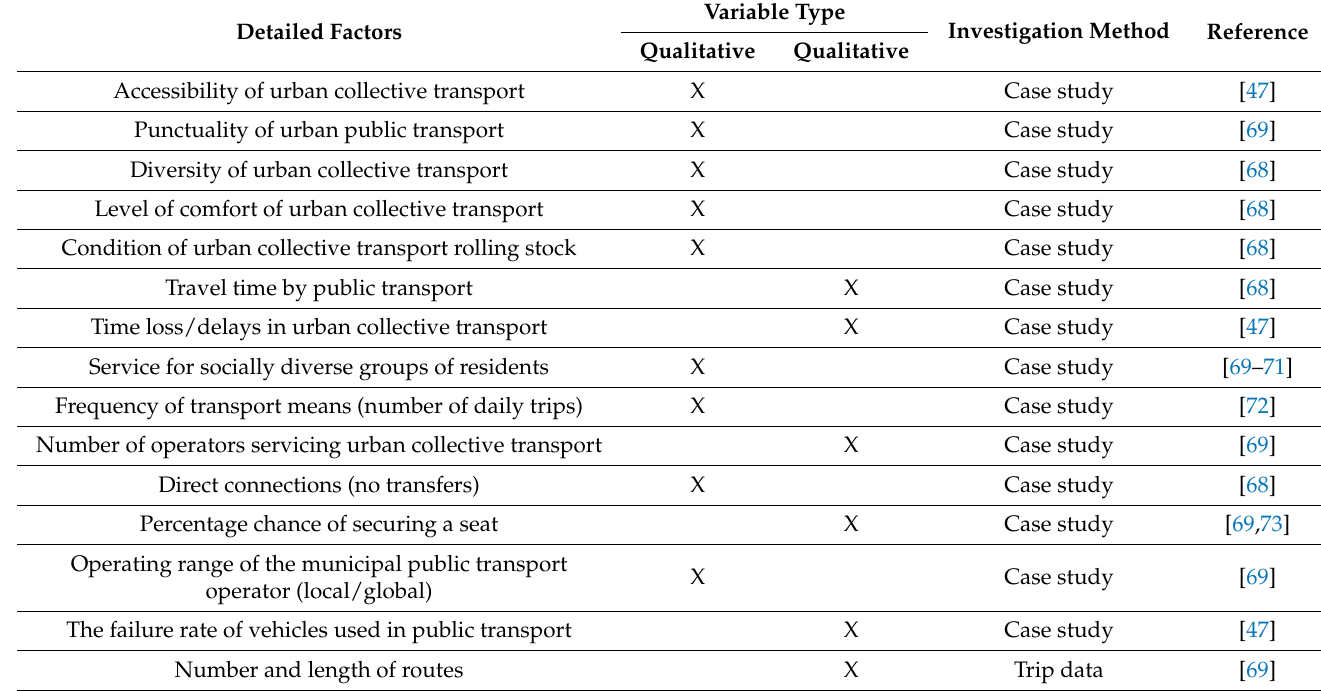
Table 9. Factors related to urban collective